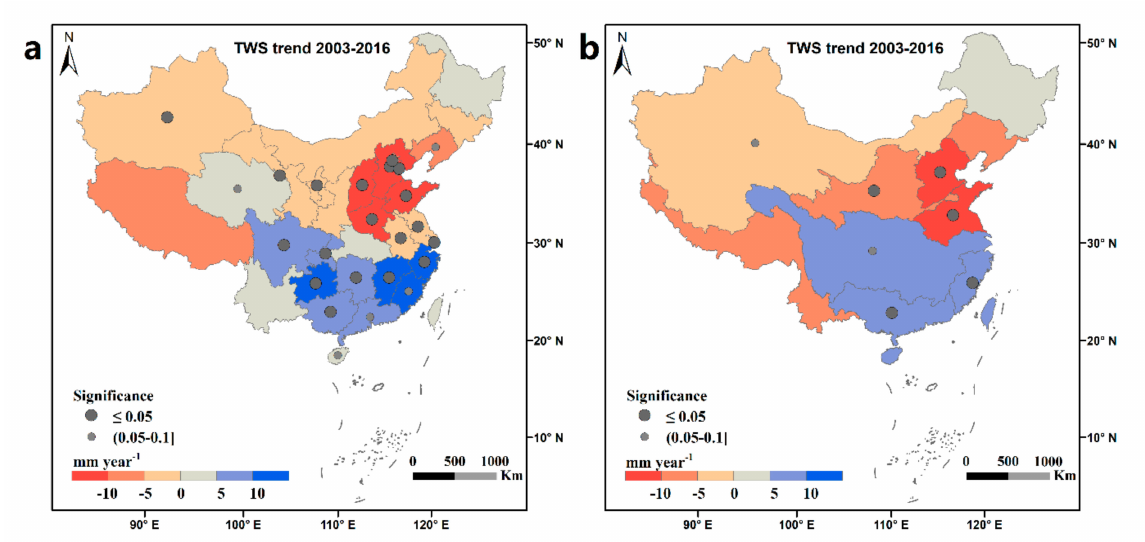
Figure 4. The spatial distribution pattern of the trend in terrestrial water storage for the period 2003–2016. ( a ) Per the province. ( b ) Per the